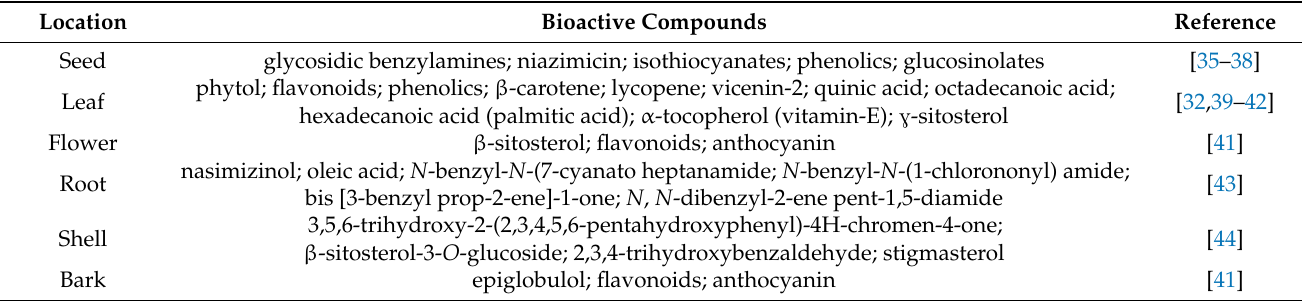
Table 1. Major bioactive compound in different body parts of M. oleifera